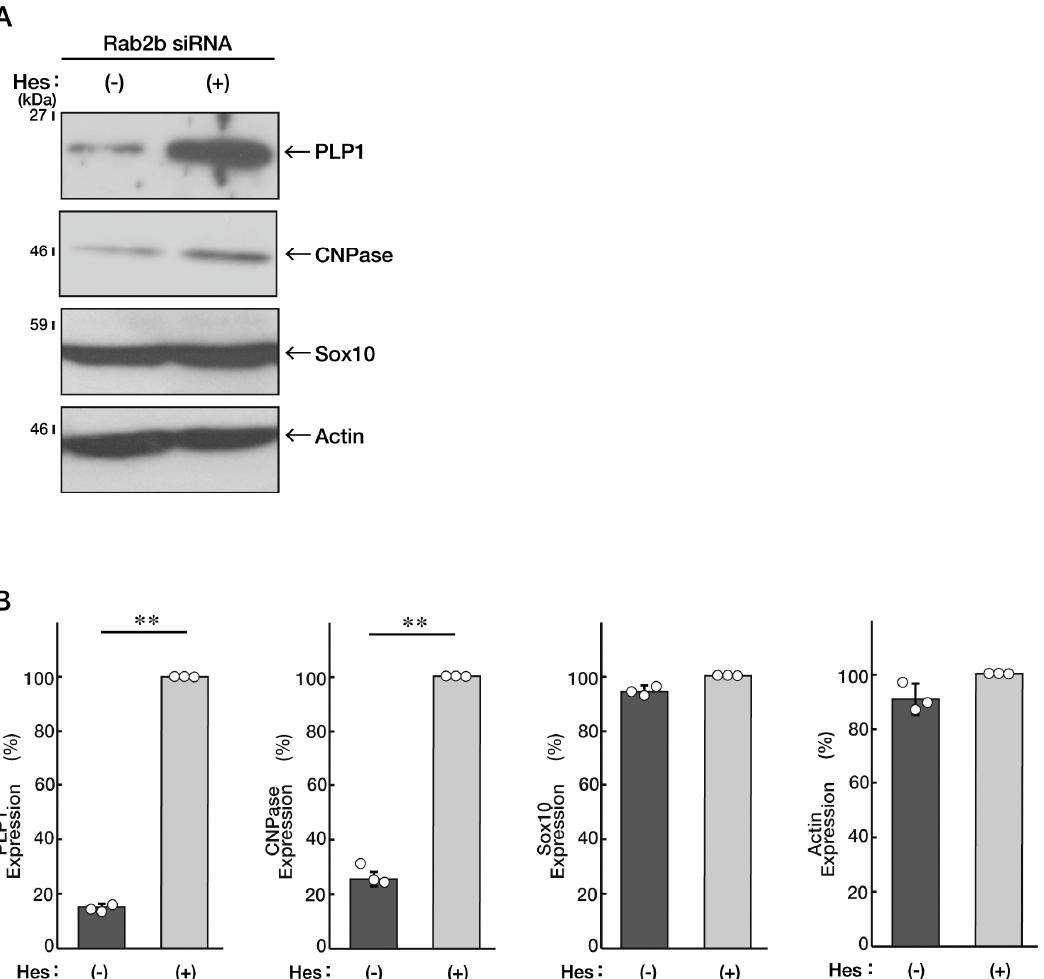
Figure 10. Hesperetin recovers decreased marker protein levels induced by Rab2b knockdown in FBD-102b cells. ( A , B ) FBD-102b cells were transfected with Rab2b siRNAs and treated with a control vehicle (minus Hes) or hesperetin (plus Hes, 1 μ M) for 3 days. Each cell lysate was collected for an immunoblotting for an antibody against PLP1, CNPase, Sox10, or actin. Immunoreactive bands were quantitatively calculated compared to the respective controls (100%) and statistically depicted as graphs (** p < 0.01; n = 3 blots). White circles show percentages in the respective independent experiments.